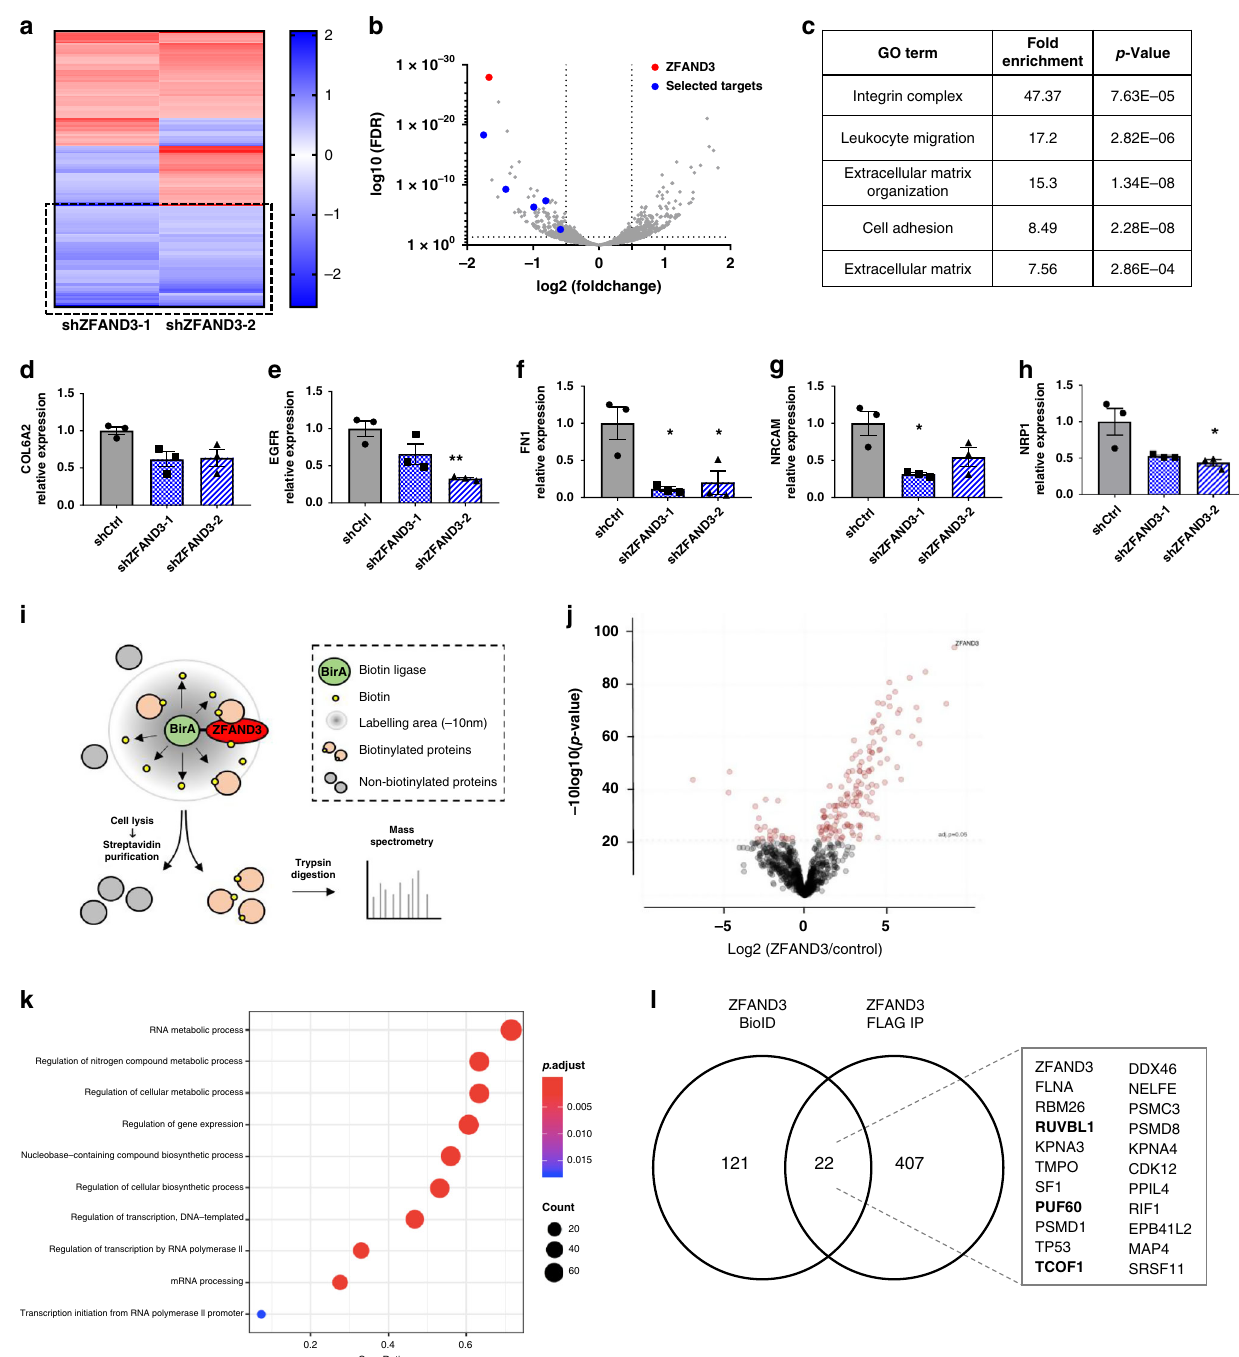
Fig. 6 ZFAND3 regulates gene expression and is part of a nucleus-speci fi c protein interactome involved in RNA metabolism, processing, and transcription. a RNAseq analysis of HI GSCs ( n = 3 per condition) identi fi ed 58 common DEGs from two KD clones (shZFAND3-1 and shZFAND3-2) vs shCtrl cells (FDR ≤ 0.05, log2FC ≤ − 0.5 and ≥ 0.5). b Volcano plot showing DEGs in shZFAND3-2 compared to Ctrl. Among these, 5 downregulated DEGs were selected for further investigation. c Gene ontology analysis (David database) associated the 58 DEGs to invasion-related GO terms. qPCR con fi rmed reduced expression of COL6A2 ( d ), EGFR ( e ), FN1 ( f ), NRCAM ( g ) and NRP1 ( h ) in HI GSCs with shZFAND3-1 or shZFAND3-2 compared to shCtrl ( n = 3 biologically independent samples). Results are displayed as average ± SEM. Results were analysed with one-way ANOVA. i Bio-ID approach applied to unveil the interactome of ZFAND3 (adapted from Vernaite et al. 59 ) ( n = 4). j Volcano plot showing 143 proteins signi fi cantly enriched in ZFAND3-BirA expressing cells. Two-sample t test was performed with a Benjamini-Hodgberg based FDR < 0.01. k Gene ontology analysis demonstrated that these 143 proteins are involved in RNA metabolism, processing, and transcription. l Co-IP/MS in ZFAND3-FLAG expressing cells con fi rming 22 proteins from the Bio-ID experiment as candidate ZFAND3 interactors. Gene names of identi fi ed proteins are indicated, with Pontin ( RUVBL1 ), PUF60 ( PUF60 ) and Treacle ( TCOF1 ) highlighted in bold. * p value < 0.05, ** p value <